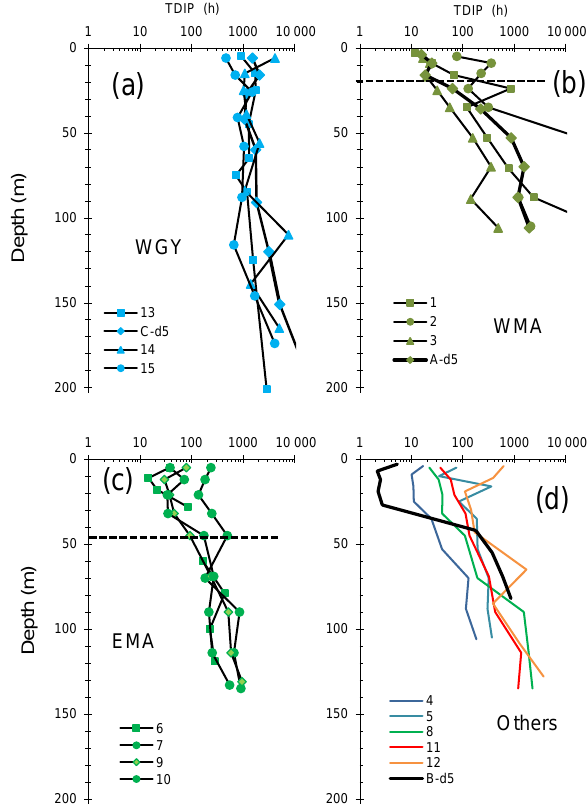
Figure 4. Vertical distributions of phosphate turnover times ( T DIP ) in groups of stations WGY (a) , WMA (b) , and EMA (c) and other stations (d) . At the long-duration sites LDA, LDB and LDC, T DIP profiles were determined at day 5 (bold lines). The horizontal bar in (b) (WMA) and (c) (EMA) delineates the mean phosphacline depth (mean ± SD: 20 ± 7m and 44 ± 10m, respectively) as deter- mined by Moutin et al. (2018). At WGY (a) , DIP concentrations were >100nM at all depths.